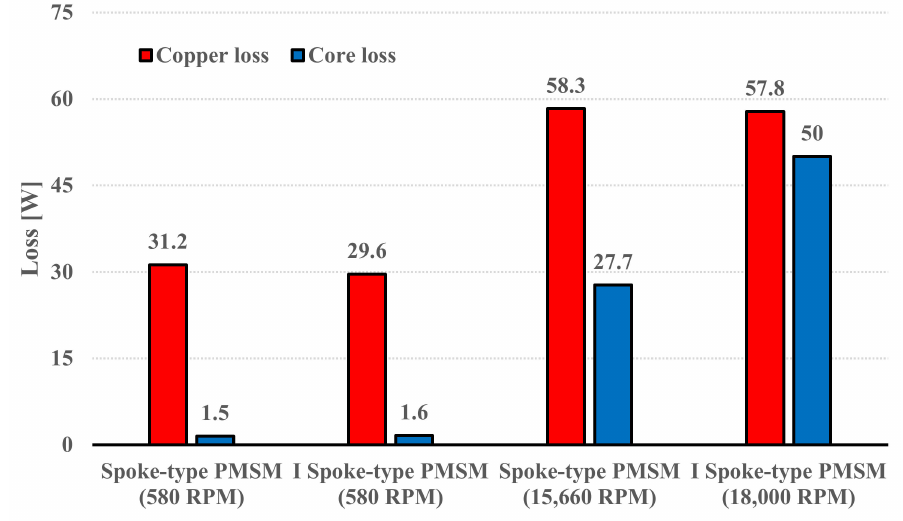
Figure 10. Loss at each operating point of both motors.